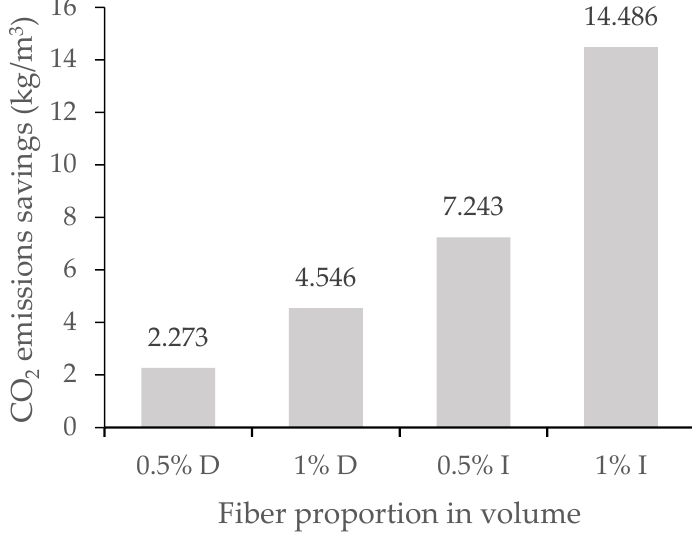
Figure 8. Direct and indirect CO 2 emissions saved per cubic meter of concrete.